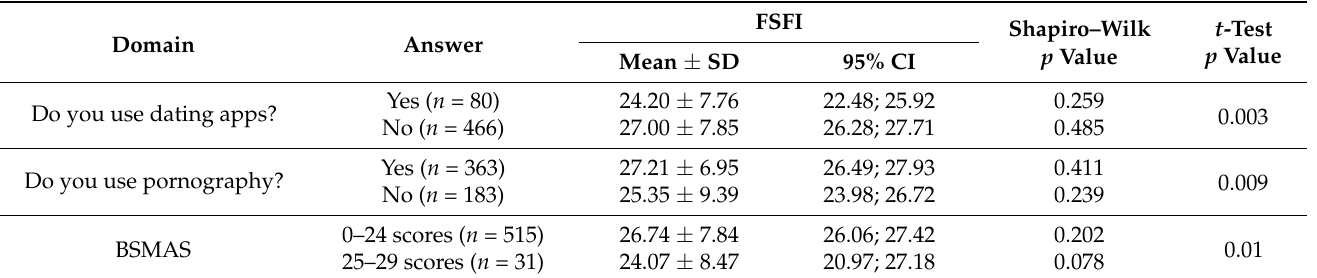
Table 4. Female Sexual Functioning Index scores in relation to the use of dating apps and pornography, as well as the Bergen Social Media Addiction Scale score.